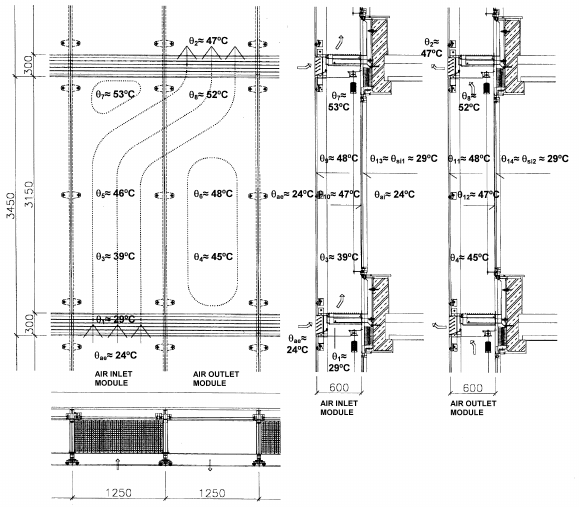
Figure 13: Natural physical cavity of double skin facade. Climate situation: period of clear windless warm weather v w ≤ 0.5 m/s. Dis- tribution of characteristic temperatures. Characteristic movement of convective air flow.